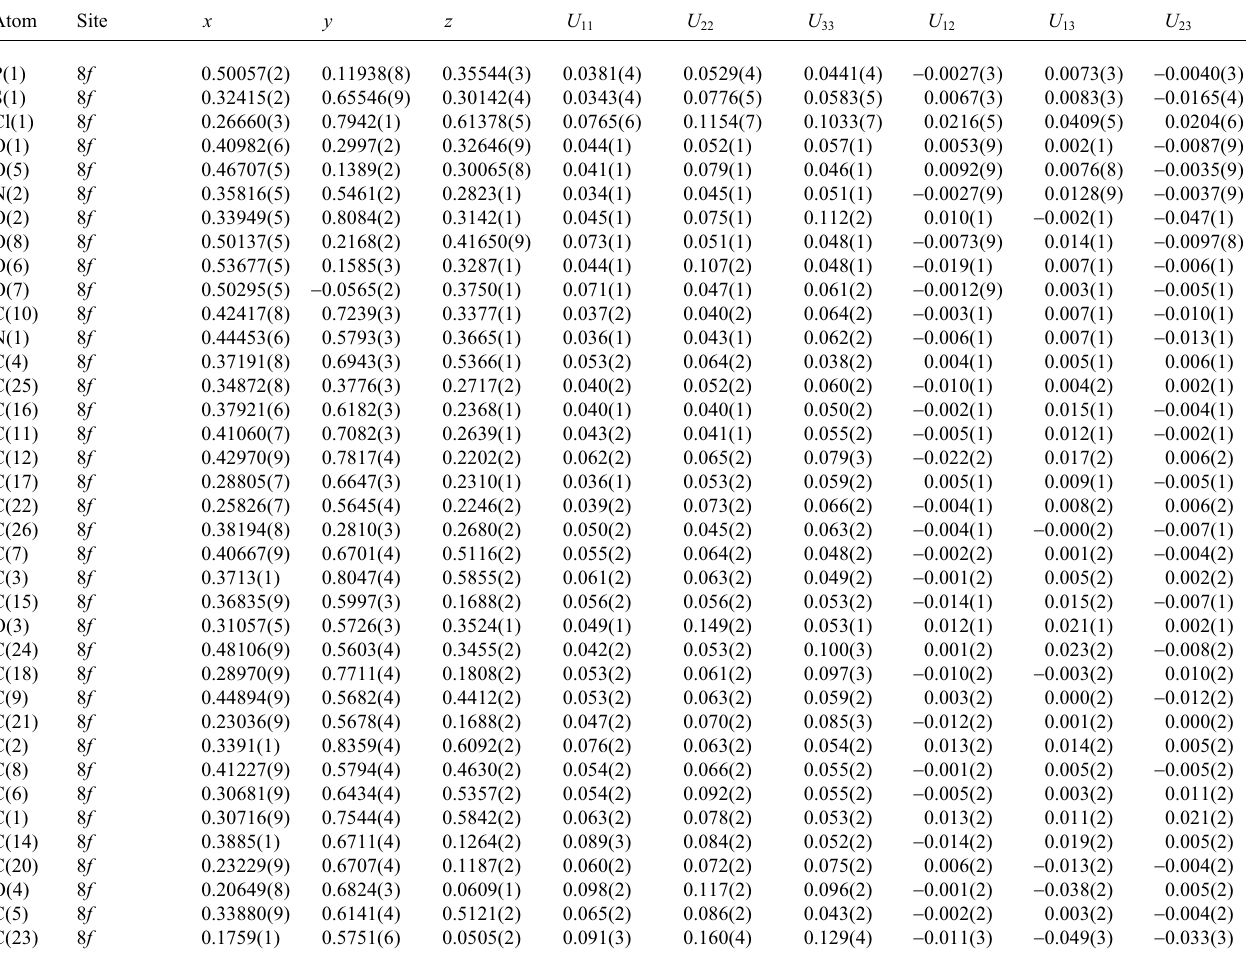
Table 3. Atomic coordinates and displacement parameters (in Å 2 ).